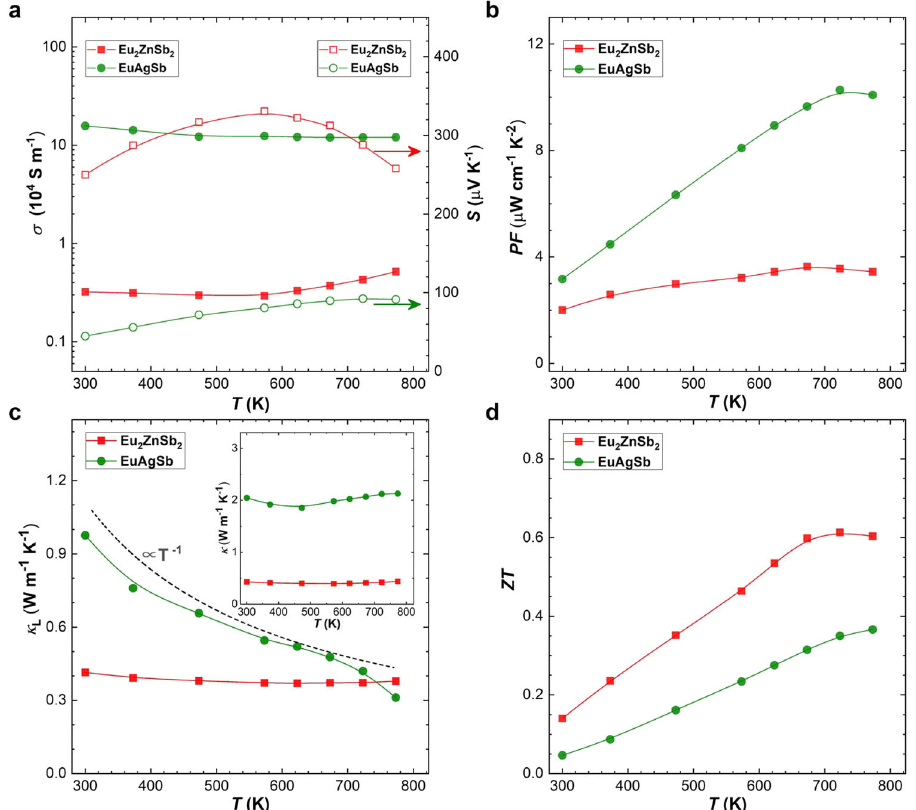
Fig. 3 Temperature-dependent transport properties. a Electrical conductivity and Seebeck coef fi cient. b Power factor. c Thermal conductivity and lattice thermal conductivity. d ZT values of Eu 2 ZnSb 2 and EuAgSb 33 .